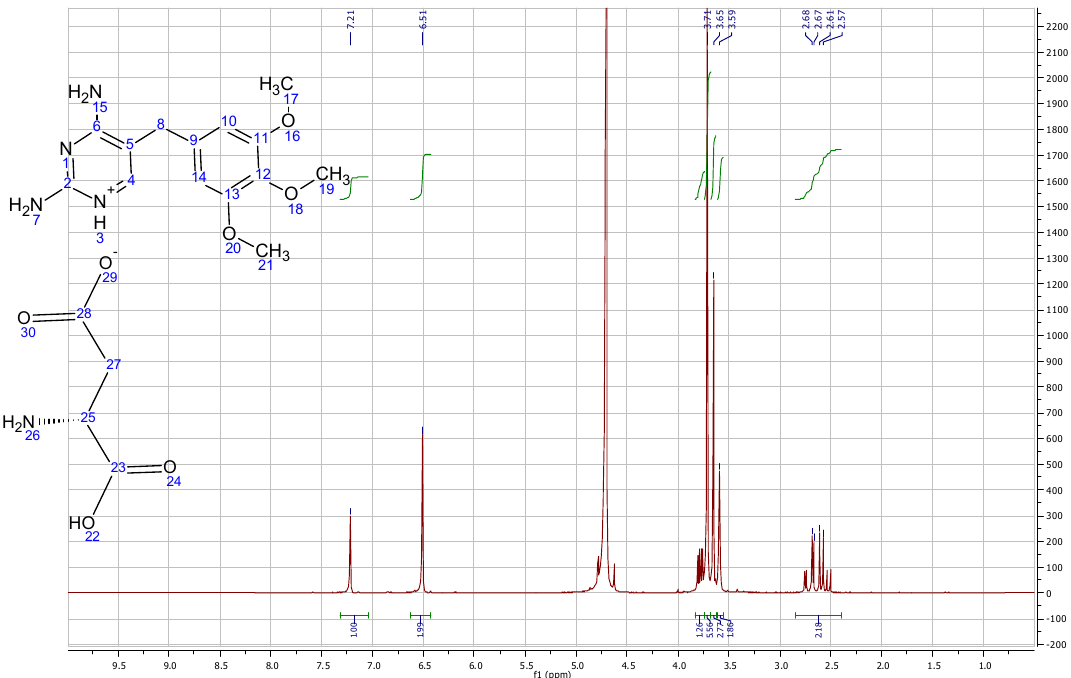
Figure B. 1 HNMR spectra of trimethoprim D -aspartate solubilized in